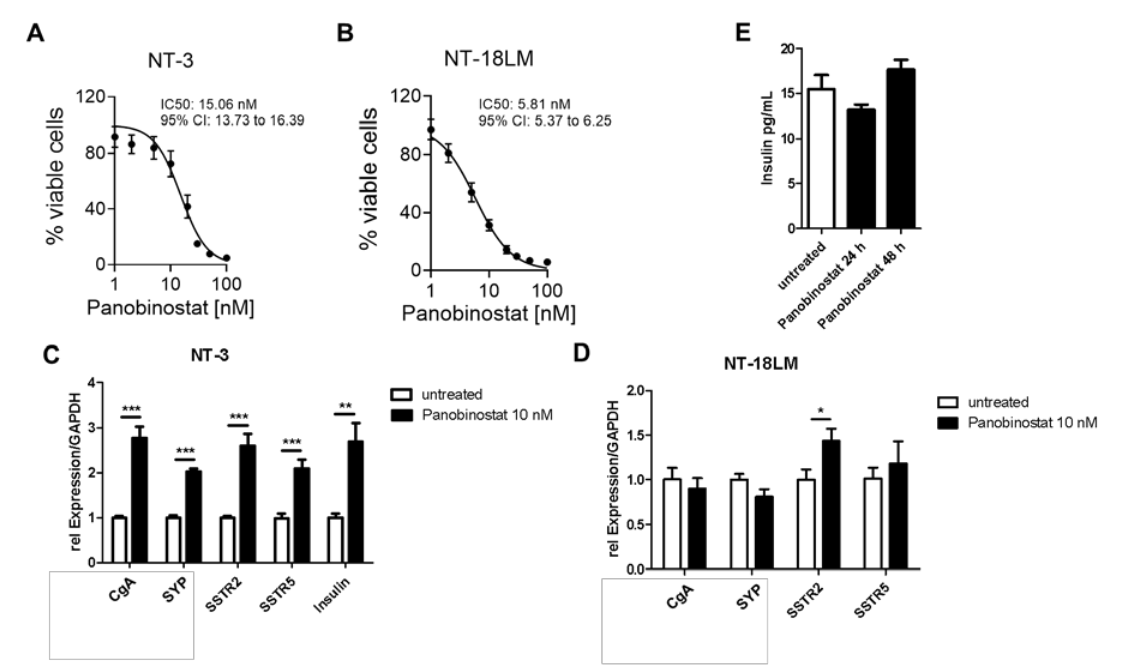
Figure 3. Panobinostat impacts the cell viability and neuroendocrine features of human NET cells. ( A , B ): NT-3 and NT-18LM cells were treated for 120 h with increasing doses of panobinostat. Panobinostat was replenished once after 48 h. IC50 was 15.1 nM (95% CI 13.7–16.4) and 5.8 nM (95% CI 5.4–6.3) for the NT-3 and NT-18LM cells, respectively. ( C , D ): Expression analyses of chromogranin A (CgA), synaptophysin (SYP), SSTR2, SSTR5 and endogenous insulin in NT-3 and NT-18LM NET cells after 72 h on RNA level. ( E ): Release of insulin in NT-3 revealed no change after treatment with panobinostat for 24 h and 48 h. * p < 0.05, ** p < 0.01, *** p < 0.001 according to an unpaired one-sample Student’s t -test.